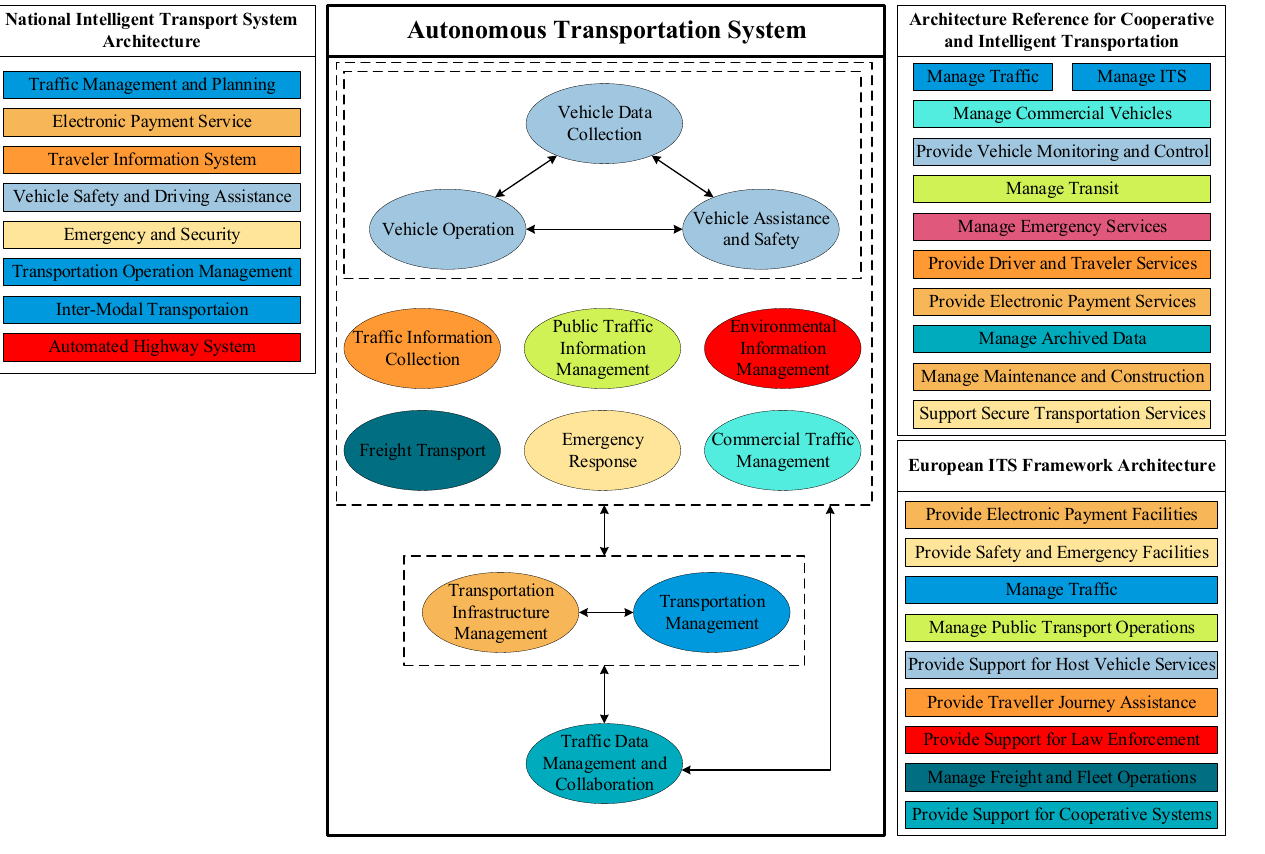
Figure 8. The relationship among function domains.